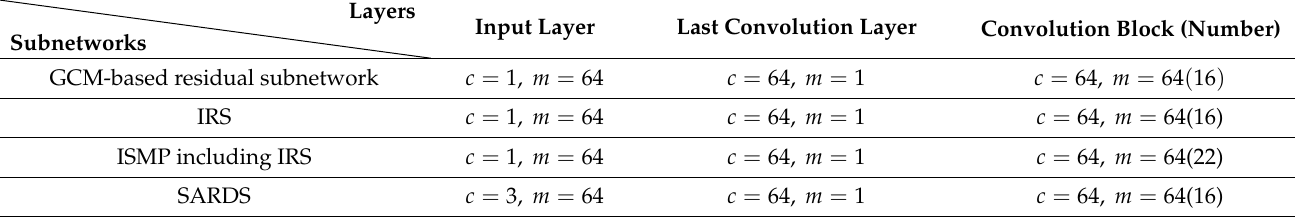
Table 1. Number of filters and channels used in convolutional layers.